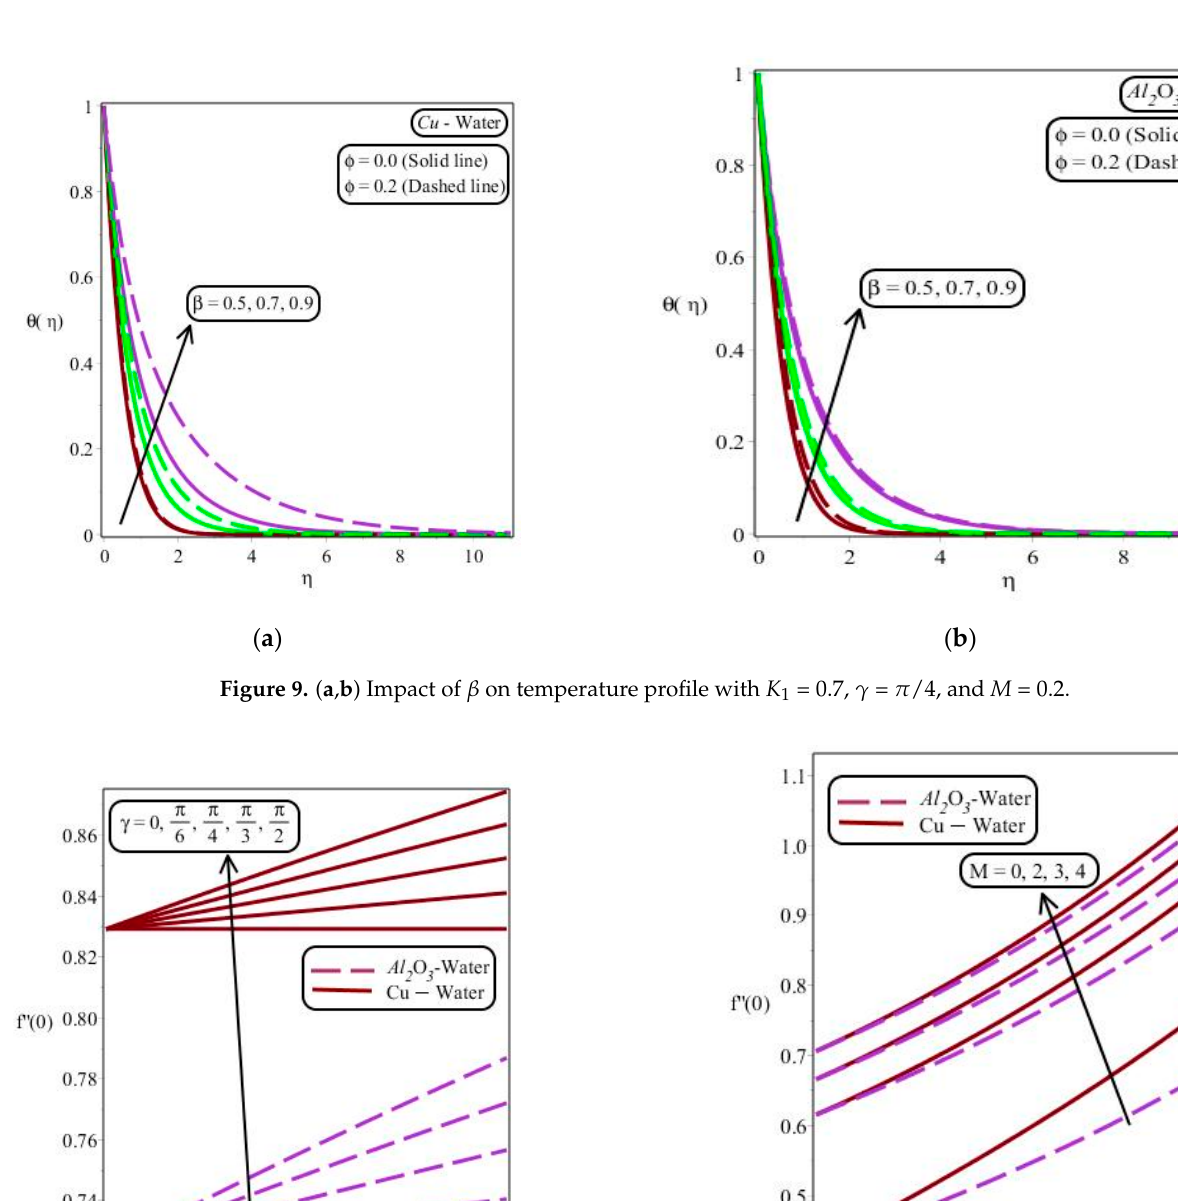
Figure 8. ( a , b ) Impact of γ on temperature profile with K 1 = 0.7 and β = 0.7.